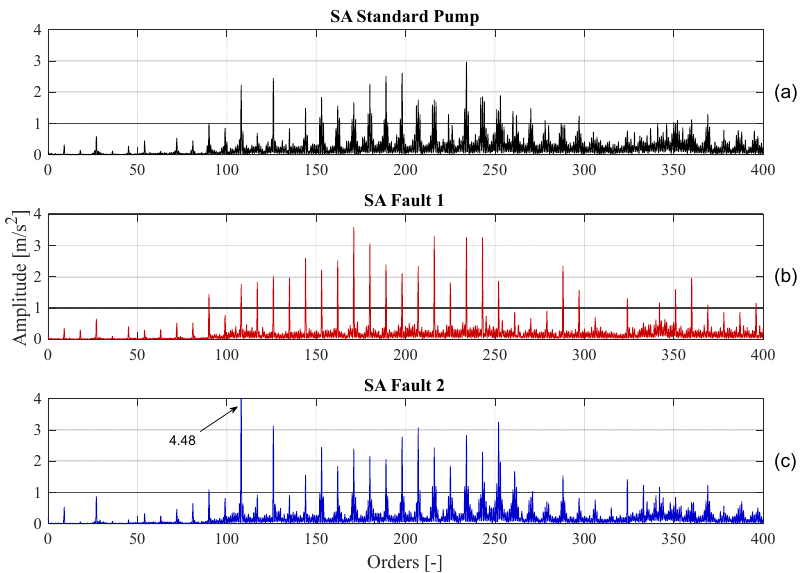
Figure 8. FFT of the synchronous average for ( a ) the standard pump, ( b ) fault 1, and ( c ) fault 2 pump for the signal acquired with sensor 1 (1500 r/min, 150 bar).